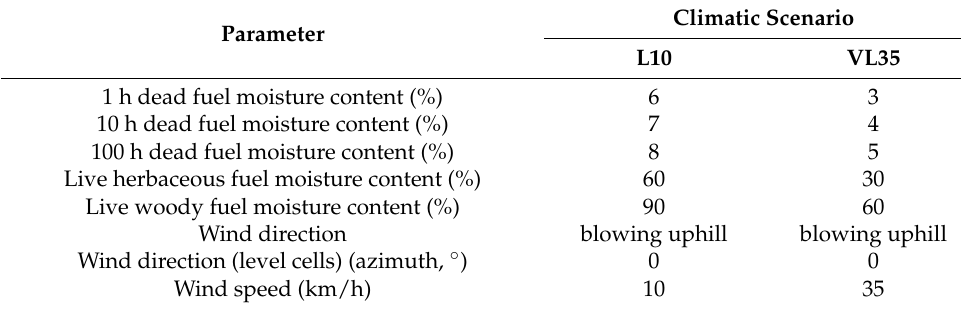
Table 2. Conditions of climatic scenarios used in the simulations of fire behavior. Parameter